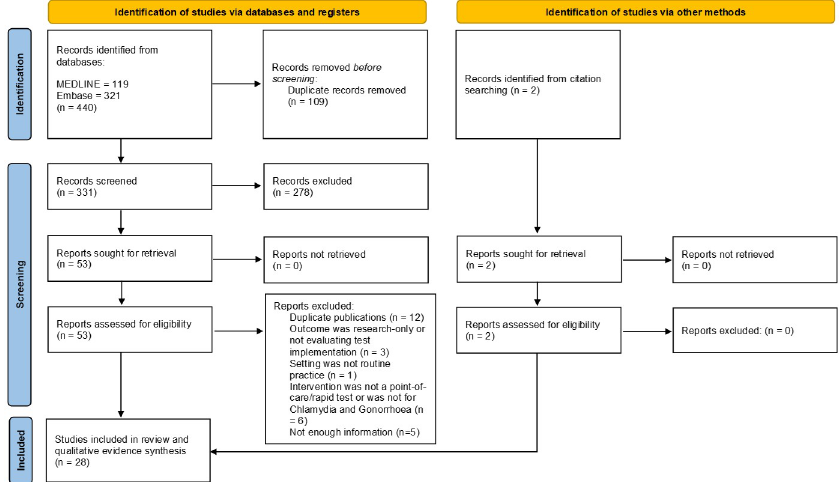
Fig 1. PRISMA flowchart [37]. From : Page MJ, McKenzie JE, Bossuyt PM, Boutron I, Hoffmann TC, Mulrow CD, et al. The PRISMA 2020 statement: an updated guideline for reporting systematic reviews. BMJ 2021;372:n71. doi: 10. 1136/bmj.n71. For more information, visit: http://www.prisma-statement.org/.